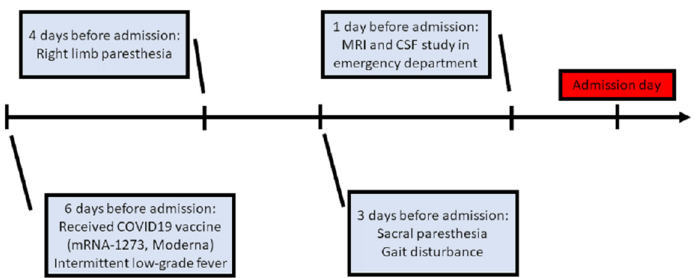
Figure 1. Clinical course before admission. (MRI: magnetic resonance imaging; CSF: cerebrospinal fluid).